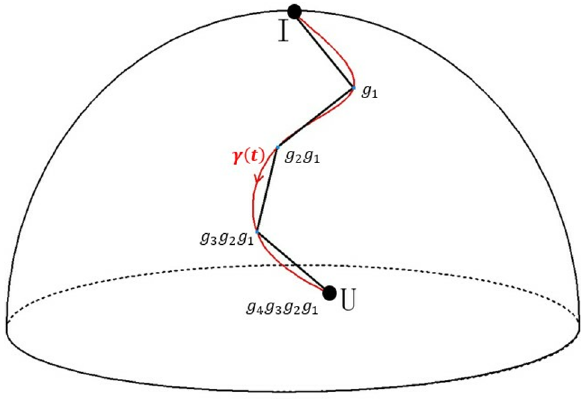
Figure 2 . The minimal number of polyline segments (black line) can be understood as the gate complexity, and the action of trajectory γ ( t ) (red line) can be understood as a smooth representation of the